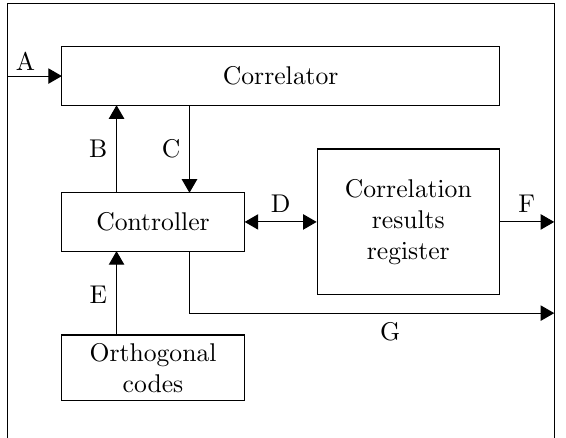
Figure 9. Complete correlation implementation with the controller, the correlator and result registers. The submodules are connected through the input samples ( A ); the code symbols of the current transmitter ( B ); the current correlation result ( C ); the access to the correlation results register of all transmitters ( D ); access to all orthogonal codes ( E ); the correlation results towards the timing module ( F ); and a signal indicating that the correlation is ready ( G